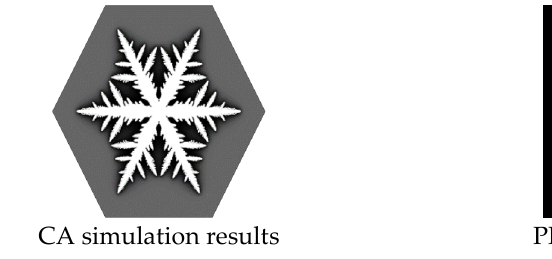
Figure 13. CA and PF simulate classic snow pattern 2.